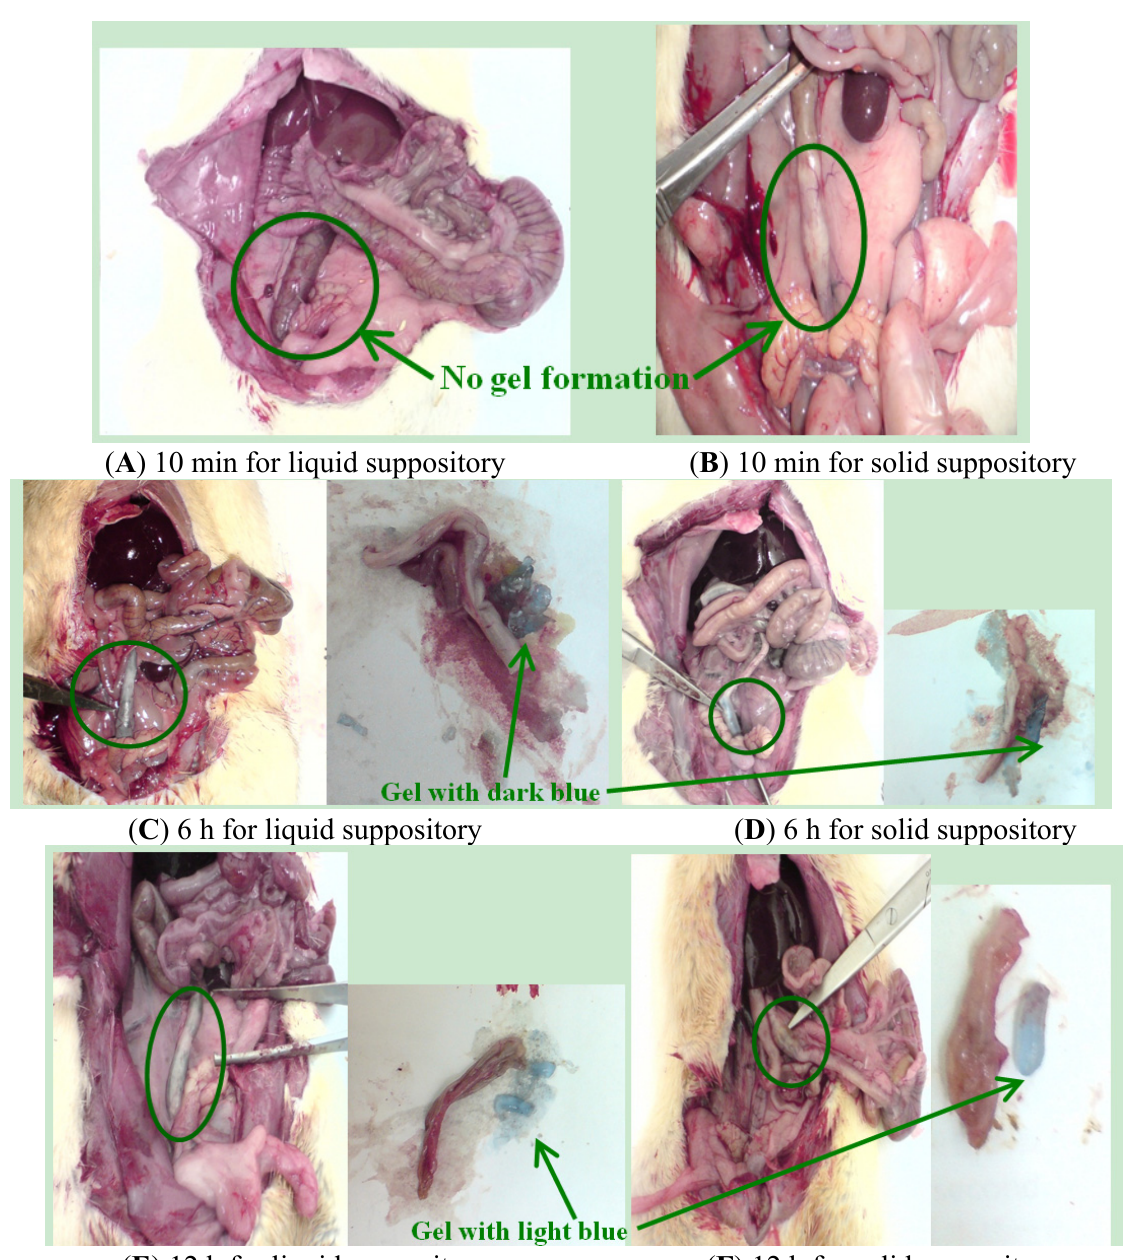
Figure 5. In vivo localization of Plu/PAA suppositories in the rectum of SD rats. Plu/PAA liquid and solid suppositories with 0.1% Toluidine Blue O were administered into the anus. ( A , B ) 10 min, ( C , D ) 6 h, and ( E , F ) 12 h after administration of liquid and solid suppositories, respectively, the rectums were sectioned. Note, the gel formation and the color change in gels from dark to light blue after 6 and 12 h of